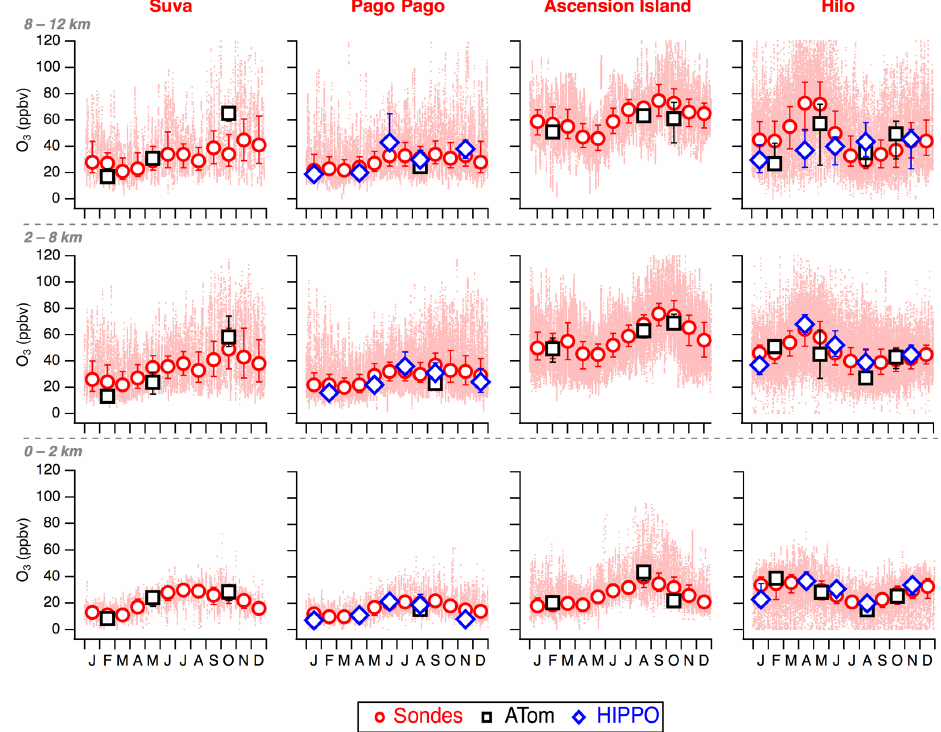
Figure 2. Comparison of ATom (black squares) and HIPPO (blue diamonds) monthly median O 3 with ozonesonde (red circles) records from the four tropical sites. Markers indicate the median, and the bars indicate the 25th and 75th percentiles. The three rows, from bottom to top, correspond to the boundary layer (0–2km), the free troposphere (2–8km), and the UTLS (8–12km). The pink dots show every O 3 data point measured by ozonesondes for the timeframes indicated in Table